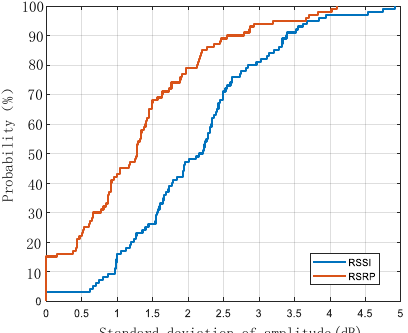
Figure 2. Measurements of RSSI and RSRP at different locations: ( a ) RSSI and RSRP distribution; ( b ) grayscale code of RSSI and RSRP.